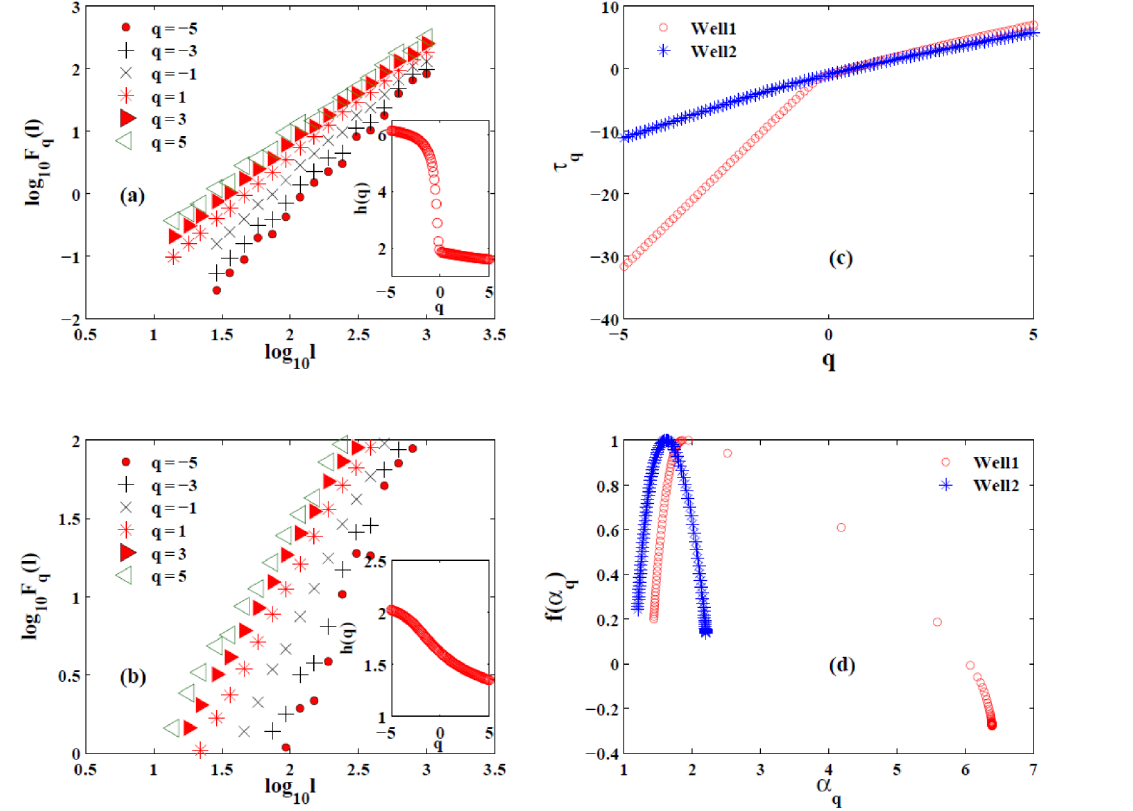
Figure 7. F q as a function of timescale l and the generalized Hurst exponent h as a function of q for the groundwater levels of (a) Well 1 (b) Well 2; (c) the scaling exponent spectrum τ q vs. the moments for the groundwater levels of Well 1 and Well 2; (d) the singularity spectrum for the groundwater levels of Well 1 and Well